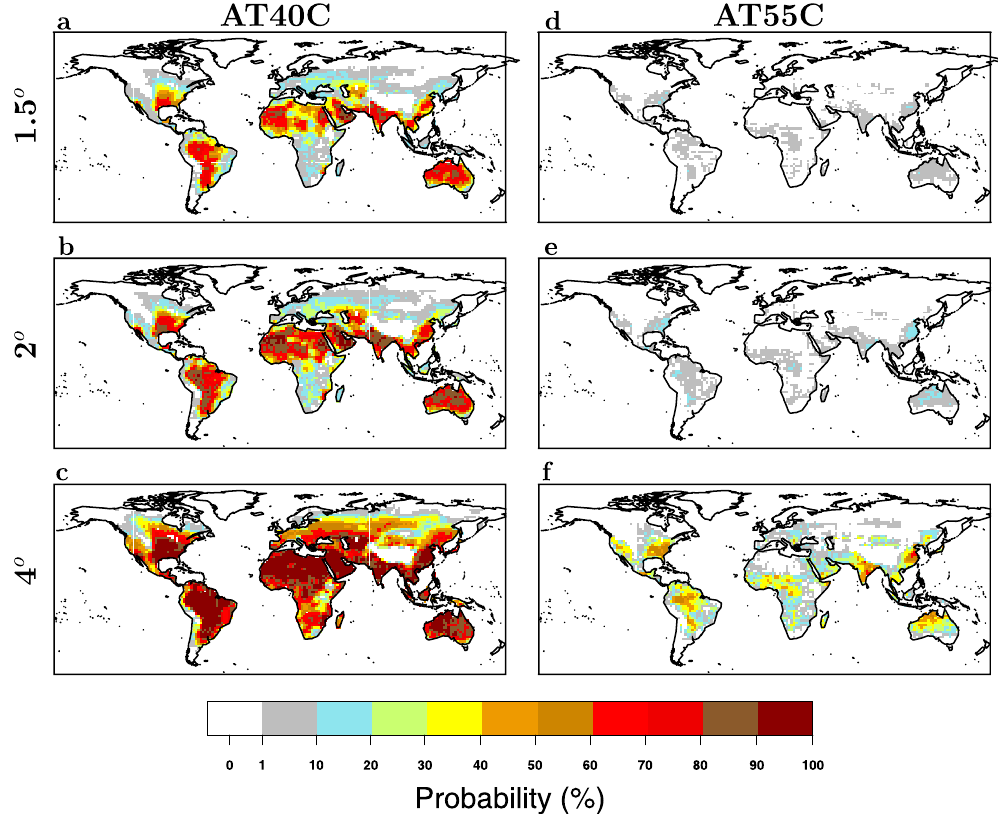
Figure 3. Annual probability of occurrence of a heat waves with apparent temperature peaks greater than 40 °C and 55 °C. ( a – c ), Probability of occurrence of heat waves with AT peak ≥ 40 (AT40C) calculated at each grid point for all model years with global mean temperature anomaly relative to 1861–1880 at 1.5, 2, and 4 degrees warming (see Fig. 2), respectively. ( d – f ), as ( a – c ) but for occurrence of heat waves with AT peak ≥ 55 (AT55C). This figure has been produced using R version 3.3.2